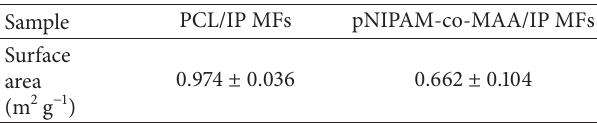
Table 1: Surface area of PCL/IP and pNIPAM-co-MAA/IP